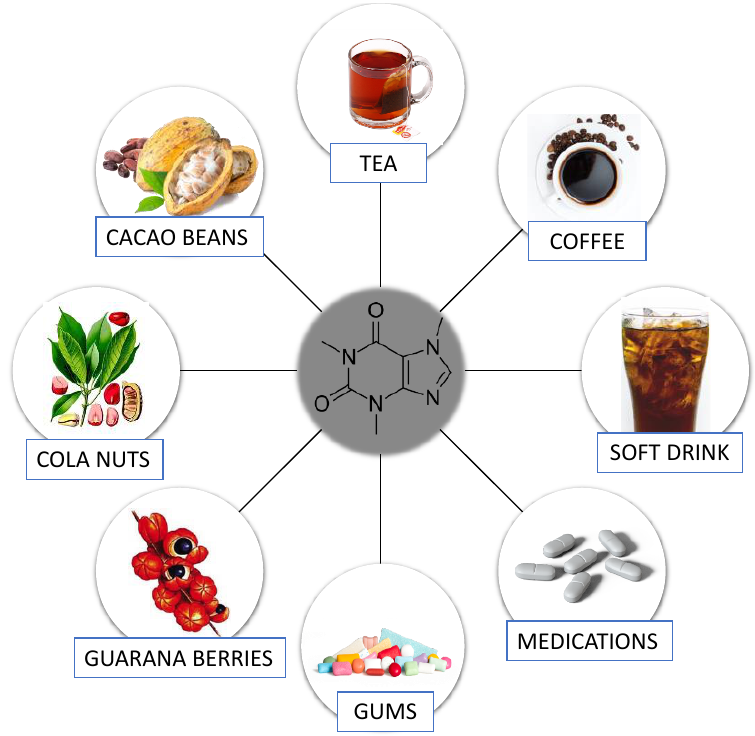
Figure 1. The most popular plants and products containing caffeine. Based on de Mejia et al.